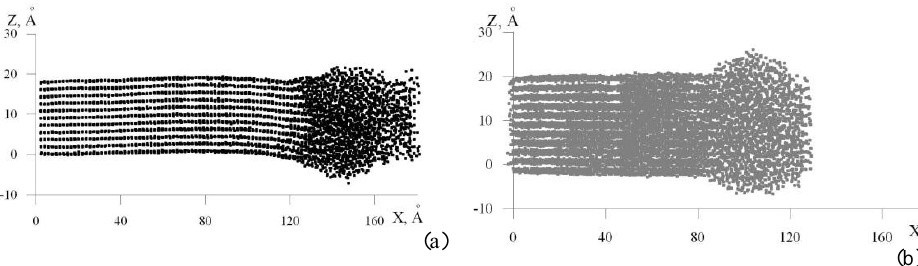
Fig. 12. Outlook of the initially perfect nanorod (а) at the time instant 20 ps and amorphized nanorod (b).